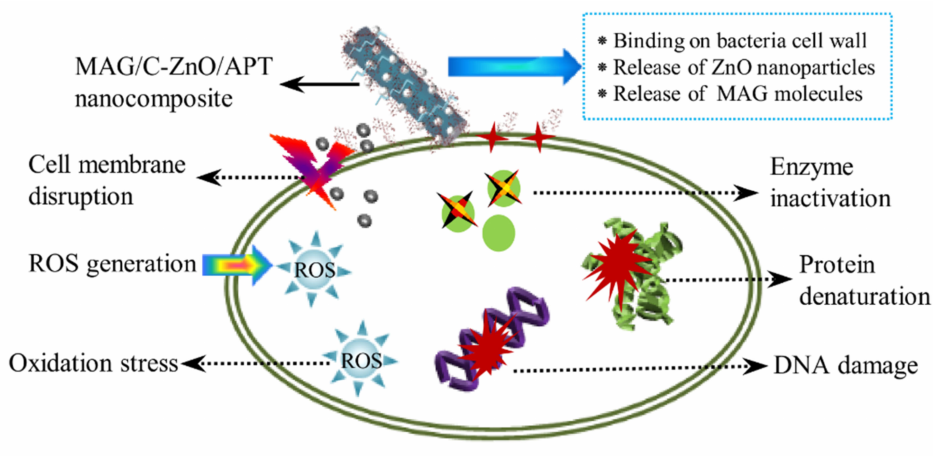
Figure 7. Possible mechanisms of MAG/C–ZnO/APT